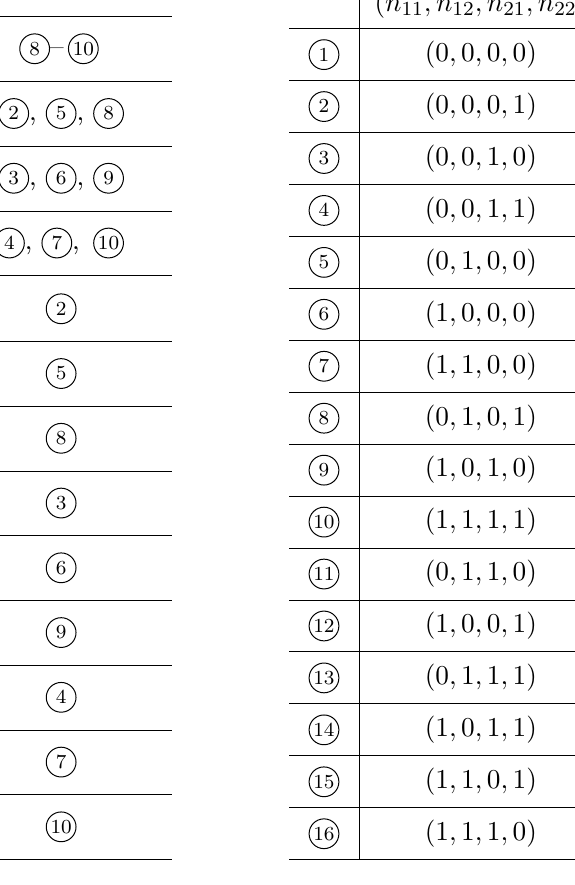
Table 24 . mod 2 structure.